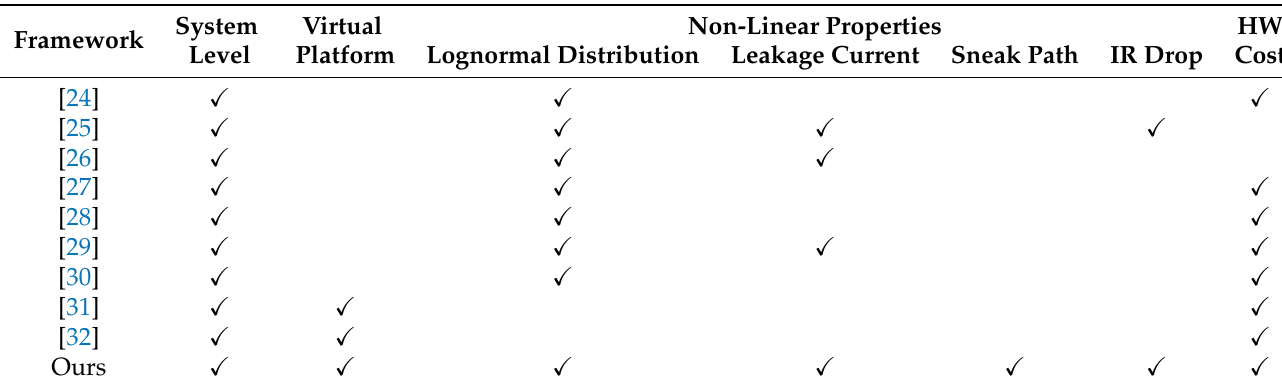
Table 1. Comparisons of the proposed design framework with previous works.